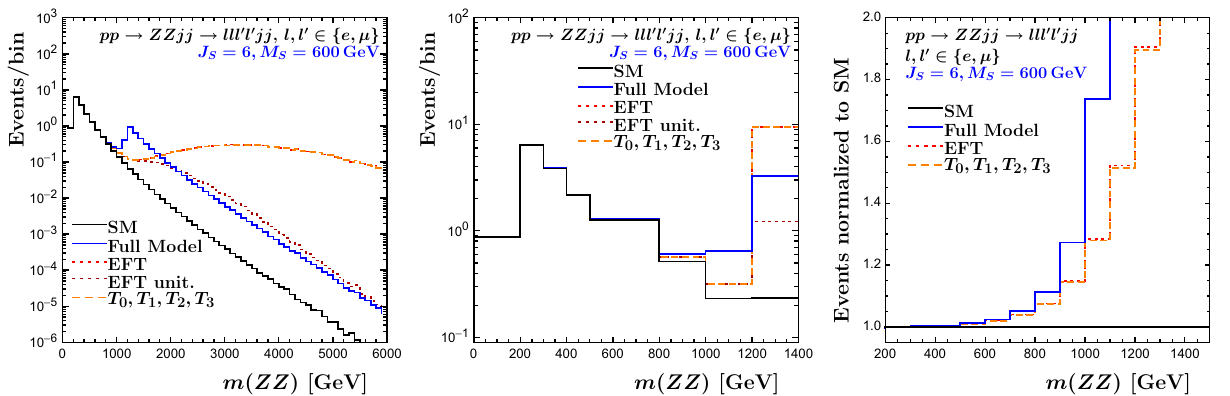
Fig. 13 Diboson invariant mass distributions for Z Zjj VBS events at the LHC. Shown are events per 100GeV bin (left), events per bin, sized as in Refs. [46,47] (middle), each for an integrated luminosity of